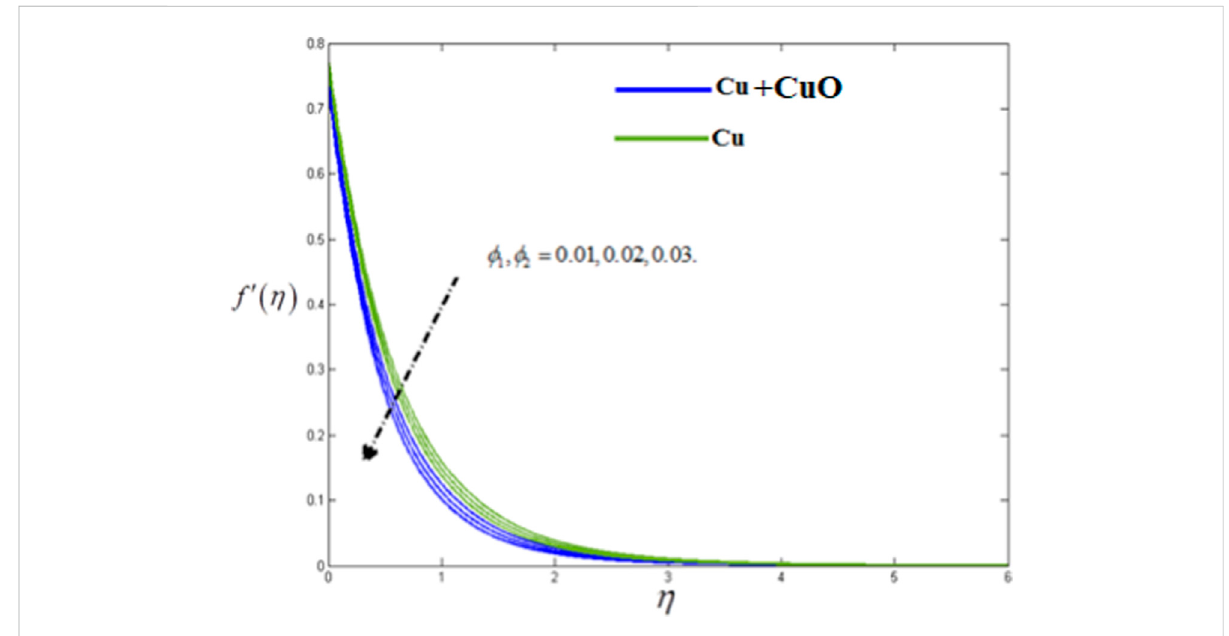
FIGURE 4 ϕ ϕ ′ ( η ) ). When, k (cid:2) 0 . 2 , Λ (cid:2) 0 . 4 , Gr (cid:2) Gr * (cid:2) Rd (cid:2) 0 . 3 , B 1 , 2 versus ( f